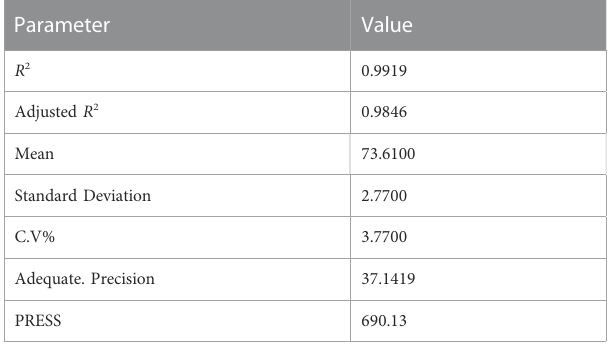
TABLE 9 Statistical information for ANOVA of quadratic